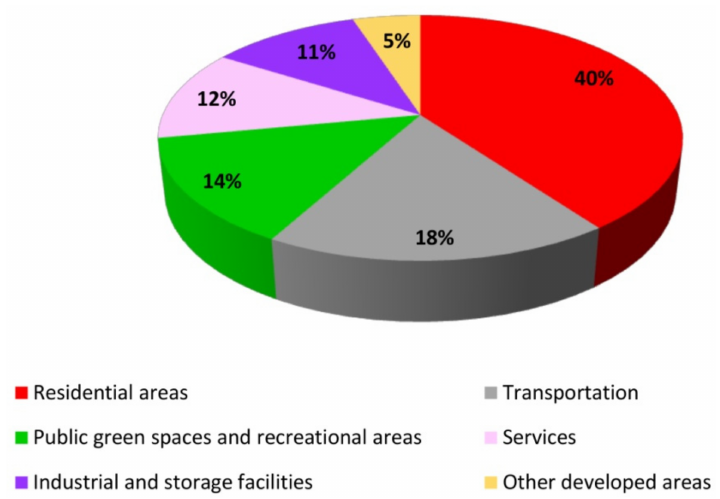
Figure 4. Land-use structure in developed areas in the town of Ostr ó da in 2017.